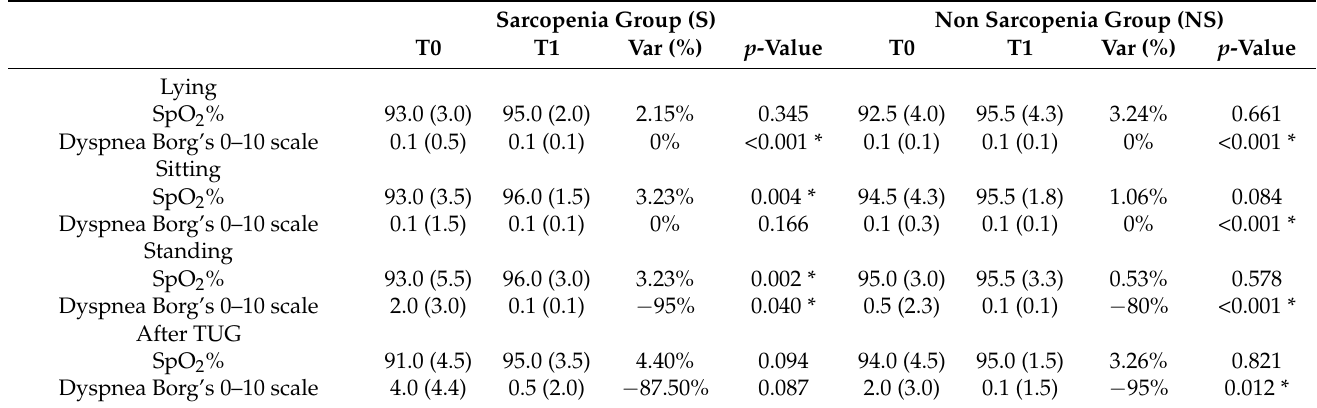
Table 2. Respiratory parameters (SpO 2 , dyspnea) measured in different positions and after TUG at T0 and T1 in the sarcopenia group (S) and the non-sarcopenia group (NS). All data are reported as mean ± standard deviation (SD).